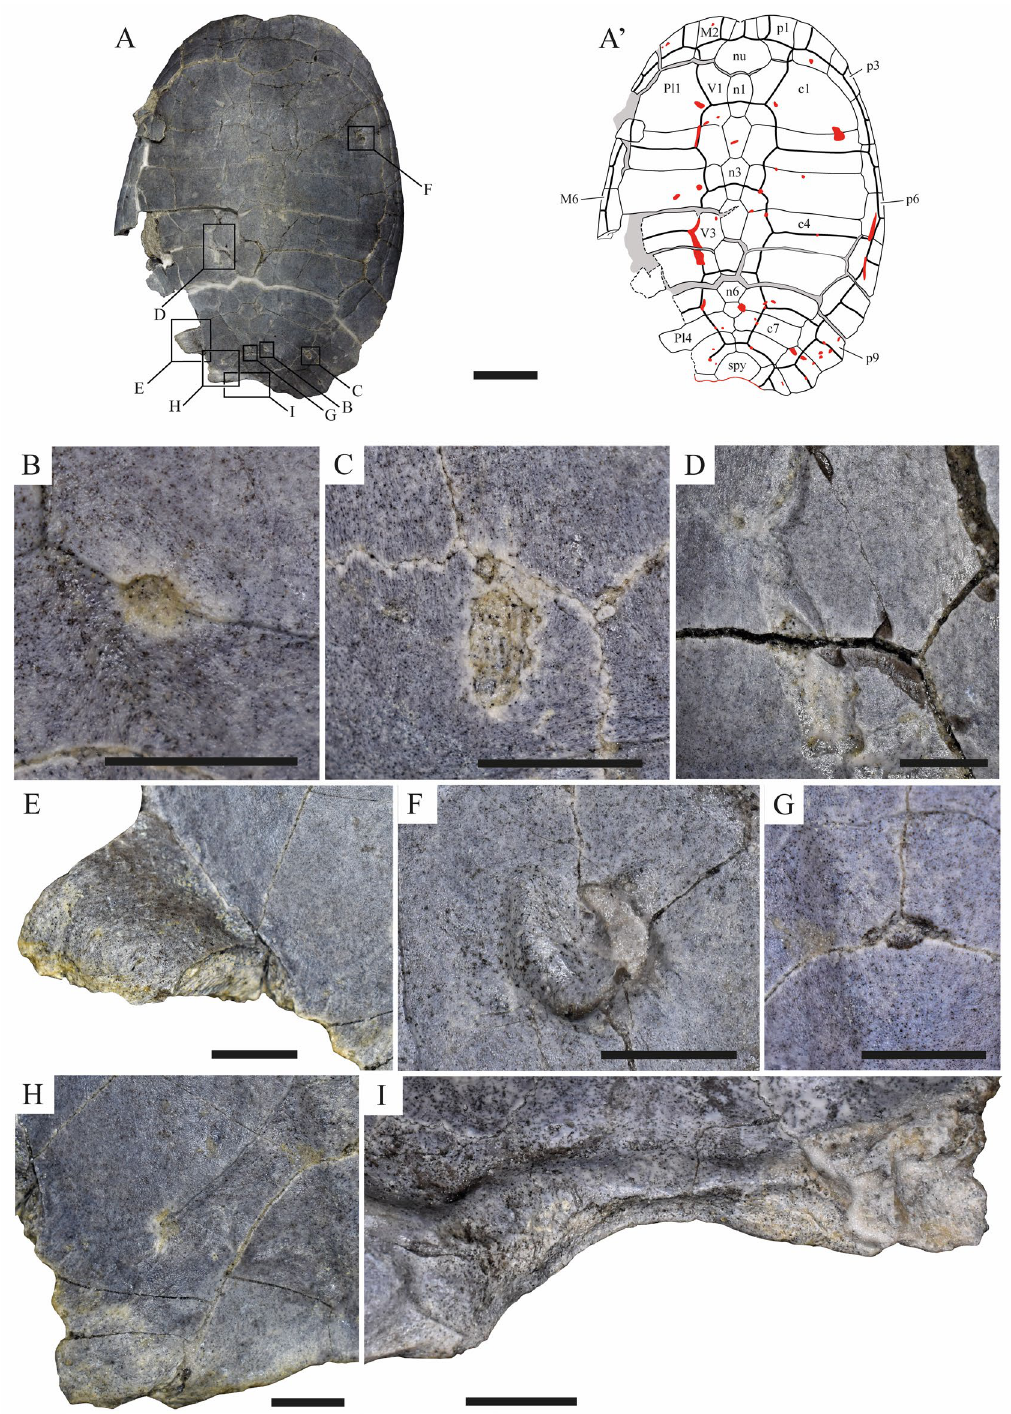
Figure 1. STUS 14024, anomalous carapace of a Neochelys sp. (Pleurodira, Podocnemididae) from the middle Eocene (Lutetian) of El Tejar fossil site, at Corrales del Vino (Zamora, Spain). ( A , A’ ) dorsal view. ( B – I ) detail of some of the anomalies identified on the dorsal surface of the carapace: pits ( B , G , H ), grooves ( C , D ), a hole ( F ), and the abnormal absence of the posterior region of the carapace ( E , H , I ). Scale bars equal 5 cm in ( A , A’ ), and 1 cm in ( B – I ). Abbreviations for the plates (in lowercase and normal type): c, costal; n, neural; nu, nuchal; p, peripheral; spy, suprapygal; Abbreviations for the scutes (in uppercase and in bold type): M, marginal; Pl, pleural; V, vertebral.